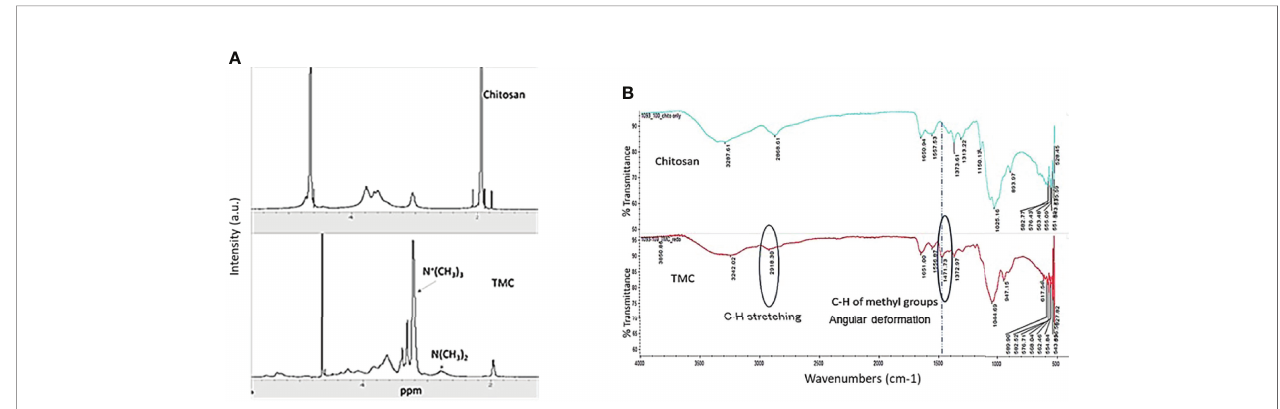
FIGURE 1 | (A) Characteristic 1H-NMR spectrum of Chitosan and N-trimethyl chitosan (TMC) in the D2O. (B) FTIR spectra of Chitosan and N-trimethyl chitosan